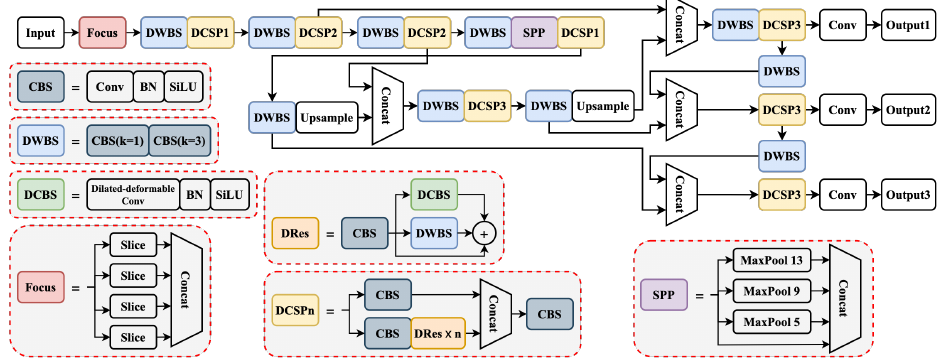
Figure 9. The architecture of YOLOG. The red-dashed boxes show the structures of each